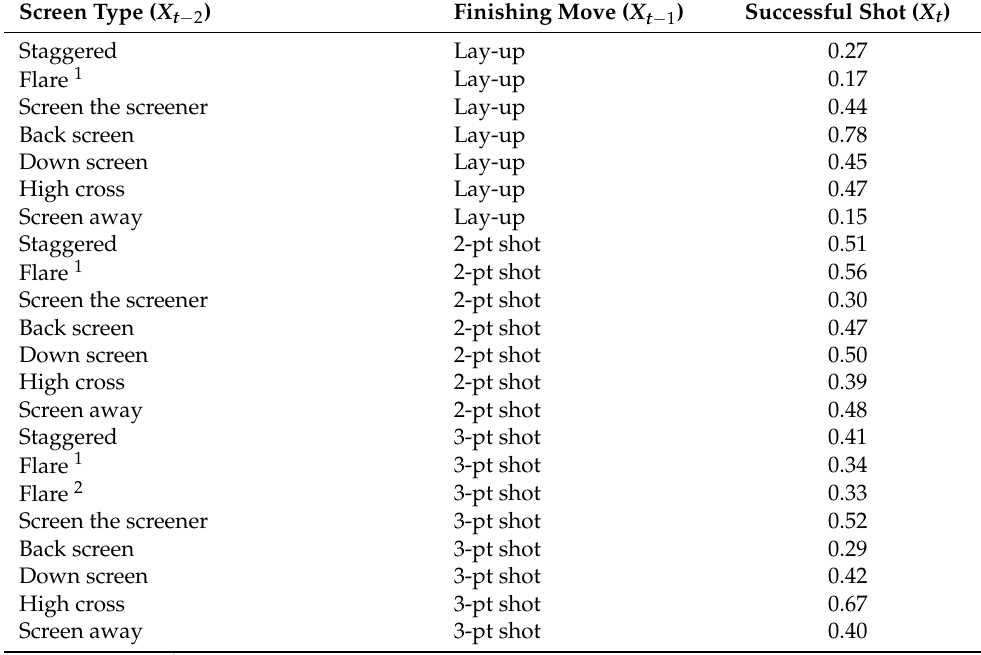
Table 5. Overall transition probability estimates between finishing moves and screens to successful